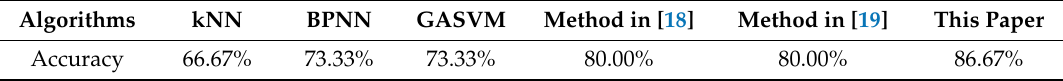
Table 13. Fault types diagnosed by proposed model and other